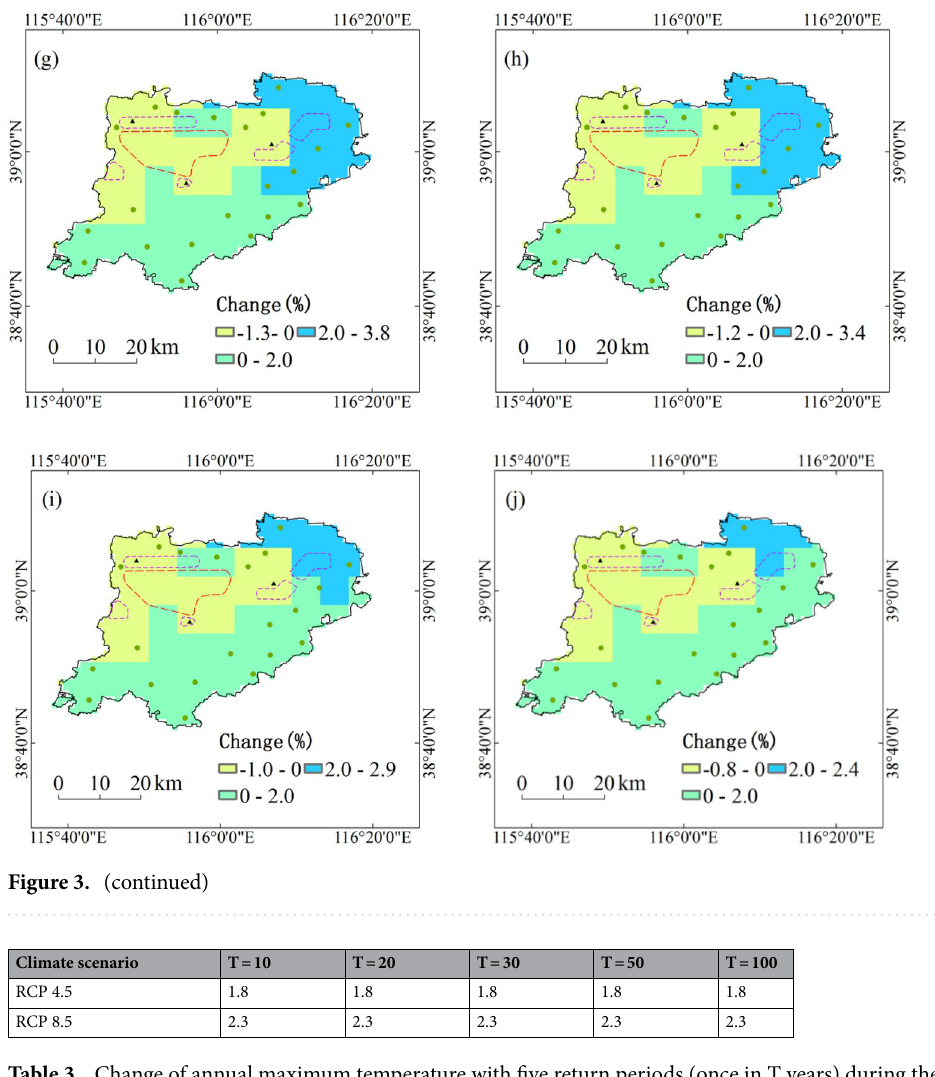
Table 3. Change of annual maximum temperature with five return periods (once in T years) during the period 1991–2050 in Xiongan New Area based on climate projection data (unit: °C).